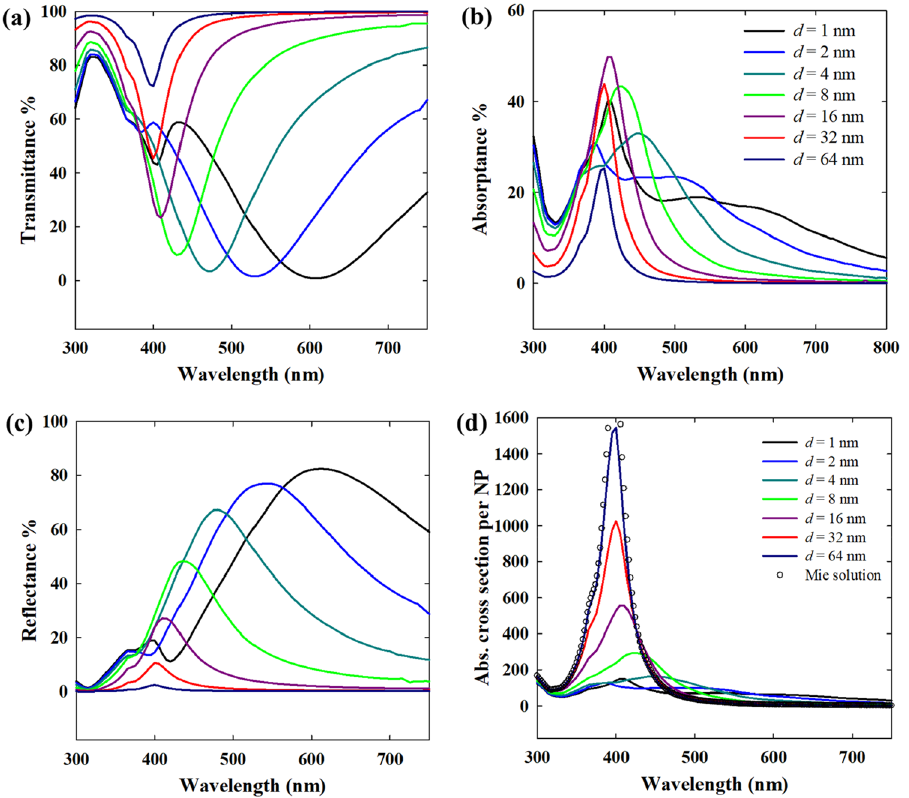
Figure 5. Effect of interparticle gap ( d ) in monolayer 2D hexagonal close packed arrays of 20 nm Ag nanoparticles in dielectric medium ( n = 1.33): ( a ) transmittance, ( b ) absorptance, ( c ) reflectance, ( d ) per particle absorption cross